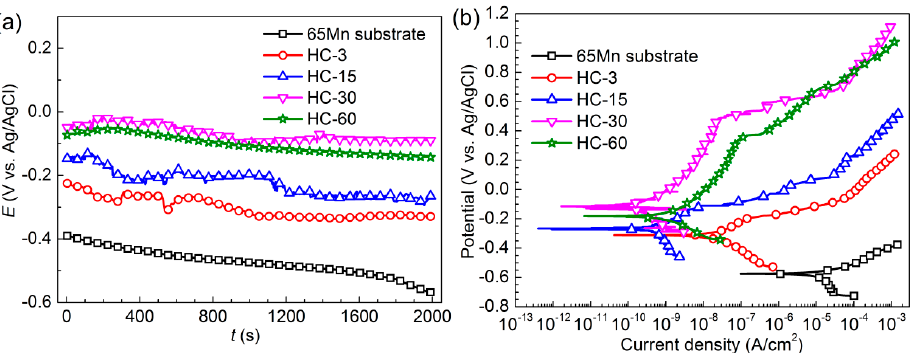
Figure 6. Open circuit potential ( a ) and potentiodynamic polarization curves ( b ) of the bare 65Mn substrate and hydrophobic coatings prepared at 80 V with different deposition times. Table 2. Electrochemical data of 65Mn substrate and the coated samples as read from potentiodynamic polarization curves.